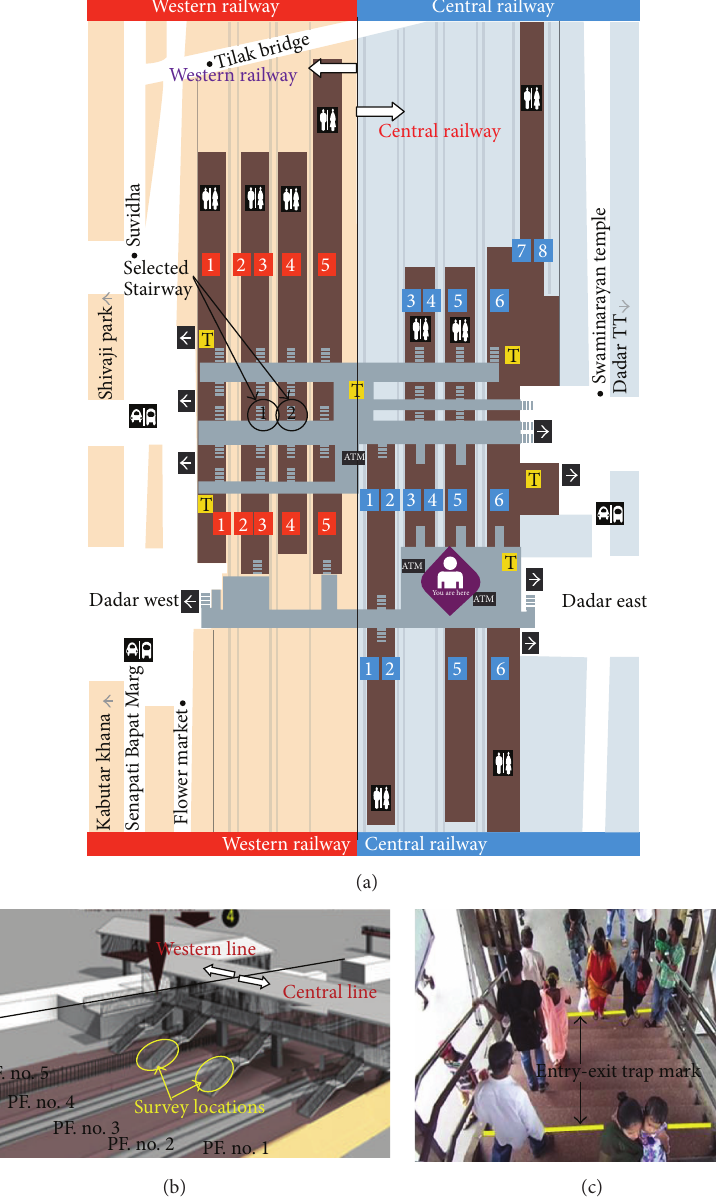
Figure 3: (a) Western and central line of Dadar suburban interchange station connected with horizontal walkway and stairways; (b) 3D view of stairway locations; (c) pictorial view of stairway having entry-exit